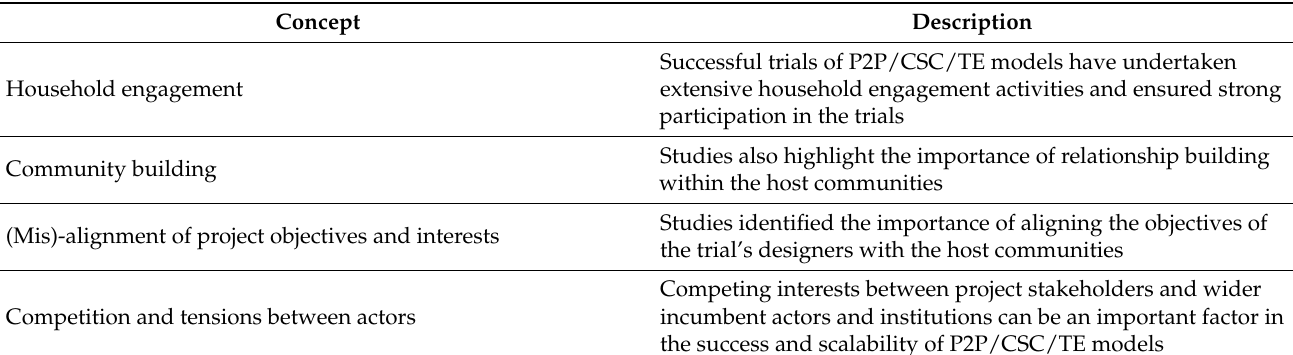
Table 6. Summary of the influence of model design and implementation on P2P, CSC and TE